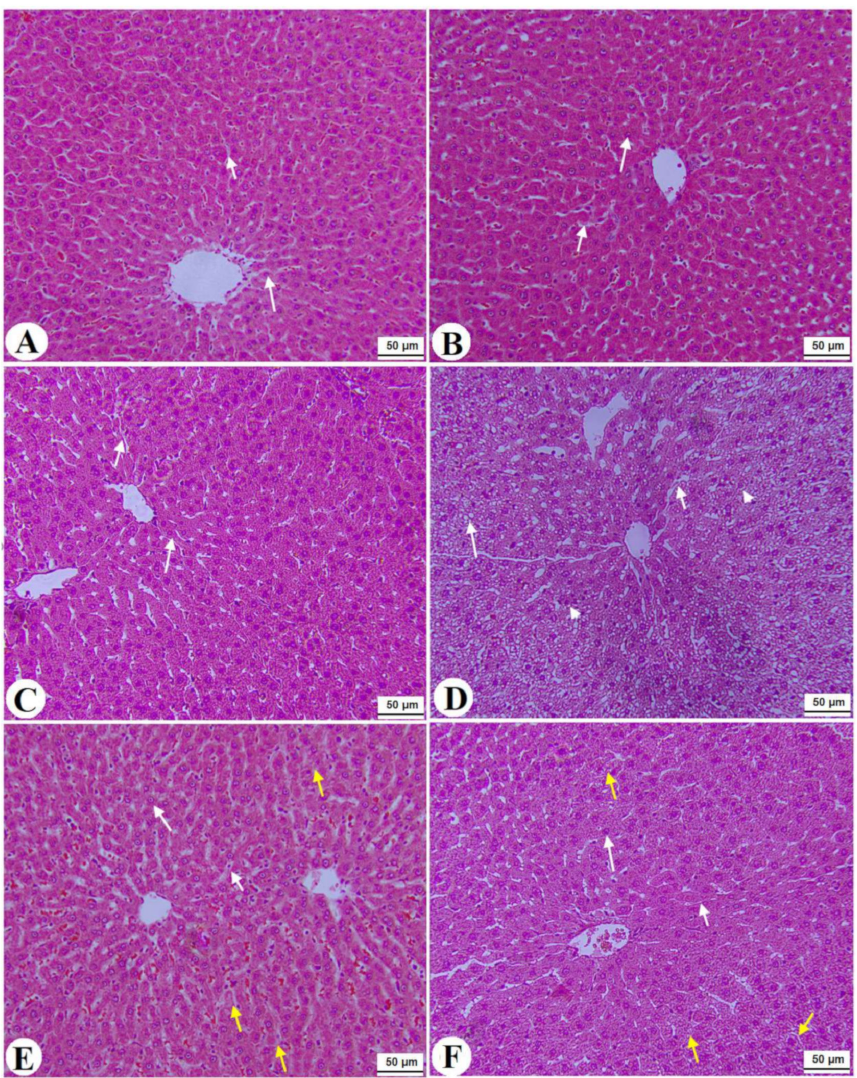
Figure 6. Histological images of the livers from all groups of rats ( A – C ): images taken from control, Fenugreek seed aqueous extract (FS-AE), and Fenugreek seeds galactomannan (F-GAL)-treated rats and showing normal liver structure with intact hepatocytes with normally rounded nuclei (long white arrow) with normally sized sinusoids (short white arrow) radiating from a central vein (CV). ( D ): was taken from a streptozotocin (STZ)-diabetic rat and showed severe fat cytoplasmic vacuoles in the hepatocyte cytoplasm of various sizes (long white arrow), dilated sinusoid (short white arrow), and an increased number of pyknotic hepatocytes (arrowhead). ( E ): Images taken from an STZ + FS-AE-treated rat and showing much improvement in the structure of the hepatocytes, where the majority of the cells and nuclei appear almost normal (long white arrow). However, some dilated sinusoids and the presence of fat vacuoles in the hepatocytes are located far from the CV (yellow arrow). ( F ): Images taken from an STZ + FS-GAL-treated rat with almost the same degree of improvement seen in T1DM + FS + AG-treated rats with almost normal hepatocytes (long white arrow) and sinusoids (short white arrow), with very few cytoplasmic fat deposits (yellow